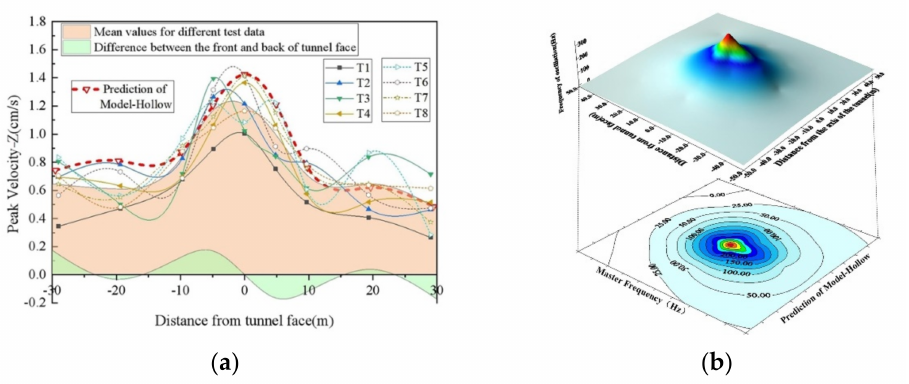
Figure 11. ( a ) Change of mean value of peak vibration velocity in the tunnel axis line. ( b ) Frequency distribution of blasting